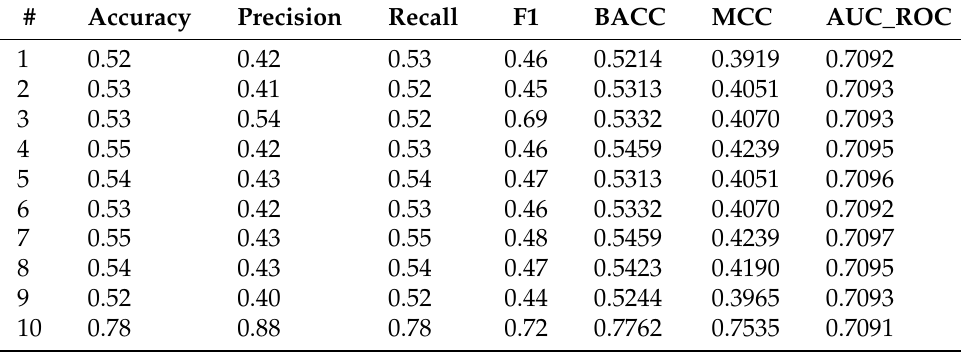
Table 10. Summary of the results for the AdaBoost Classifier.